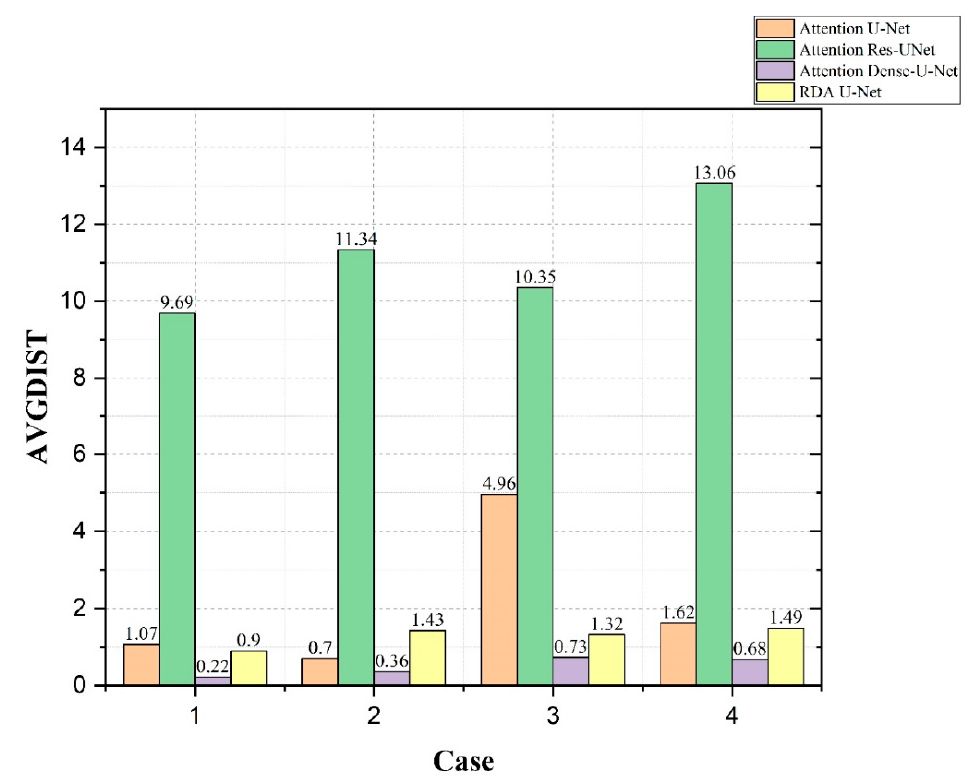
Figure 11. Comparison of AVGDIST values using Attention U-Net, Attention Res-UNet, Attention Dense-U-Net and our RDA U-Net for each of the 4 cases.